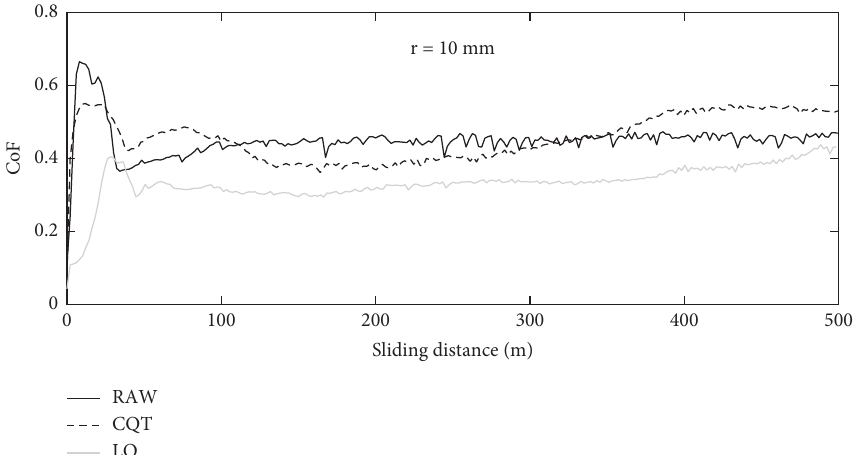
Figure 7: Friction coefficient for 500m sliding distances. Pin-on-disk tests for RAW, CQT, and LQ samples.